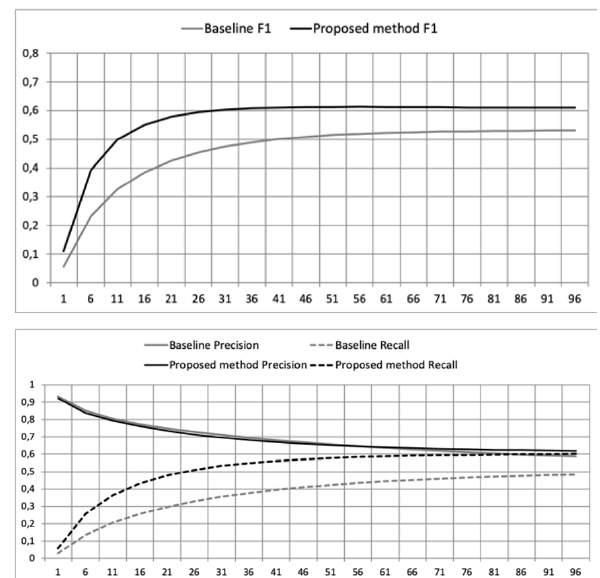
Figure 7. Netflix recommendation accuracy. Top chart: F1 comparative between the NCF baseline and the proposed RNCF. Chart below: Precision and Recall comparative between the NCF baseline and the proposed RNCF; x-axis: number of recommendations (N).